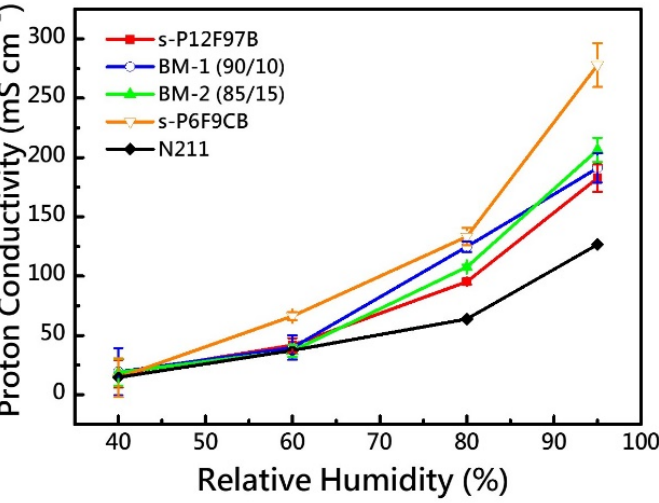
Figure 5. Proton conductivity of the N211and BM-X membranes as a function of relative humidity.